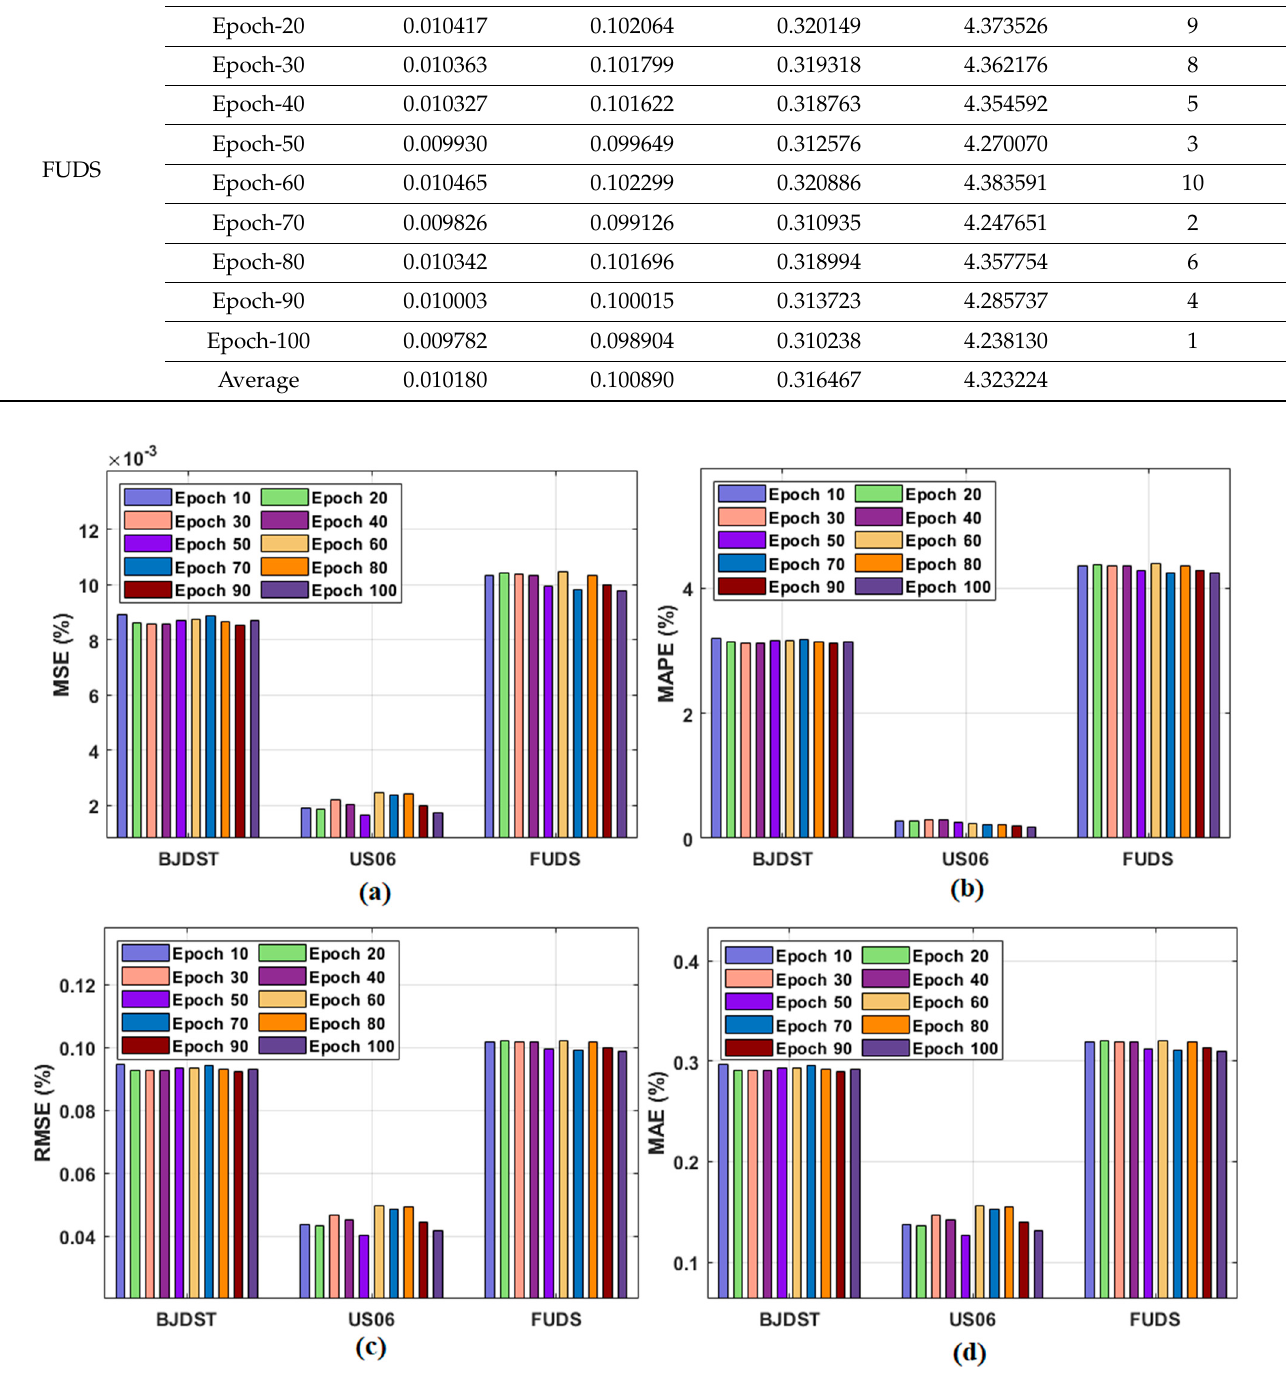
Table 2. Comparative result analysis of DLSOC-REM technique with recent approaches under different drive cycles.